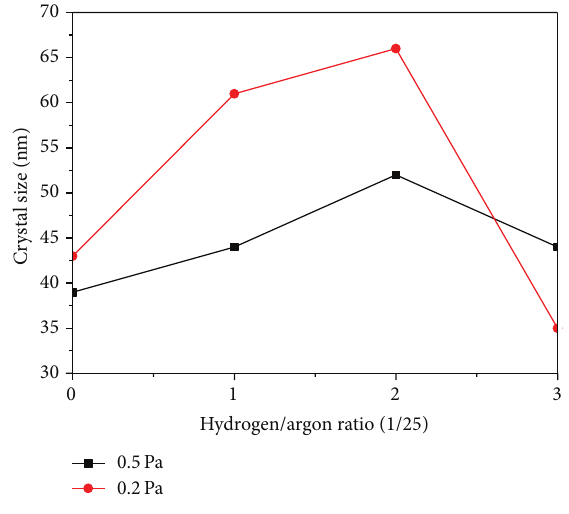
Figure 3: Crystal size ( 𝐷 ) of the ZnS thin films.